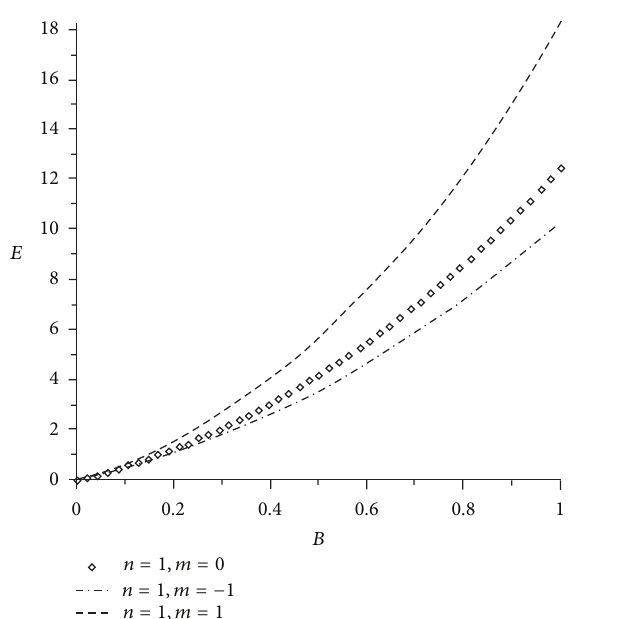
Figure 2: The energy eigenvalues versus 𝐵 (𝛽 = 1.5, 𝜂 = 0.000001, 𝑀 = 0.3) .